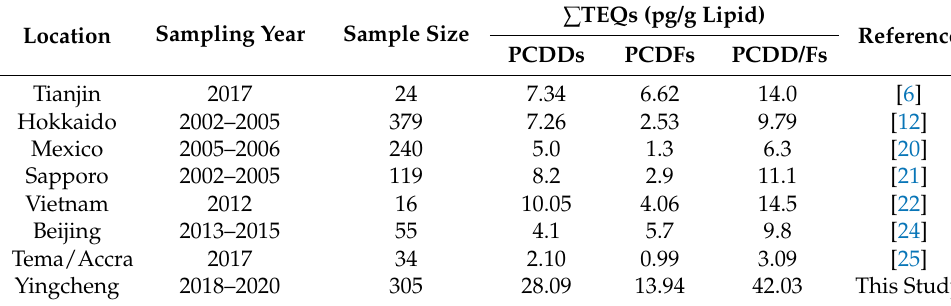
Table 5. A comparison of background TEQs with relevant